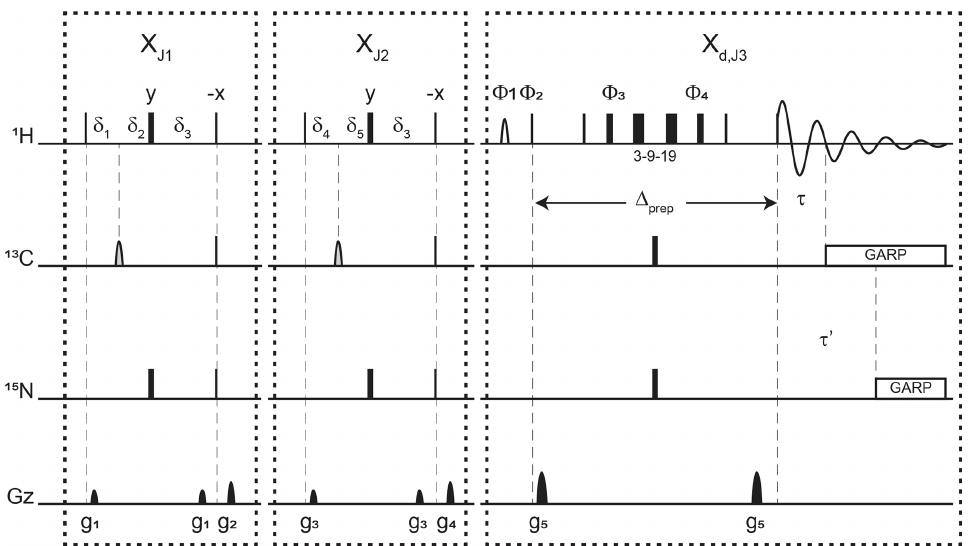
Figure 3. Pulse sequence for a 1-D double X half filter with delayed decoupling for suppression of 13 C (and/or 15 N) labeled protein signals and preservation of unlabeled moieties signals. Dashes indicate different filtering blocks that can be used modularly to suppress scalar coupled spin systems. Here, X denotes isotopic half filters and subscripts J1, J2, and J3 indicate individually targeted scalar couplings. The subscript d indicates our delayed decoupling method. Thin and thick rectangles indicate 90 and 180 ◦ hard pulses, respectively. Unless otherwise noted, the phase of these pulses is along the x axis. Open, half ellipses pulses on carbon are 180 ◦ frequency-swept chirp inversion pulses (Böhlen and Bodenhausen, 1993), with durations of either 500µs, when using sequential-tuned filters, or 1730µs, when using the chemical shift coupling matched sweeping rate (Zwahlen et al., 1997). In Bruker, the shaped pulses were Crp60, 0.5, 20.1, and Crp60_xfilt.2, respectively. Water suppression is achieved through a WATERGATE element in the X d , J3 filter employing a 3–9–19 suppression scheme (Piotto et al., 1992). A water flipped-back pulse (Grzesiek and Bax, 1993) (denoted with a curved open half ellipse) is applied on resonance with water (4.699ppm) using a 1.5ms 90 ◦ sinc pulse. The delays in the X J1 and X J2 filter blocks are δ 3 = 1 / | 4J(NH) | ≈ 2 . 78ms, δ 1 = 1 / | 4J1(CH) | , δ 4 = 1 / | 4J2(CH) | , δ 2 = 1 / | 4J(NH) |− 1 / | 4J1(CH) | , and δ 5 = 1 / | 4J(NH) |− 1 / | 4J2(CH) | . The delays τ and τ (cid:48) in the X d , J3 delayed decoupling block can each be manually set to target residual 1 H − 13 C and 1 H − 15 N signals, respectively. Although we did not need this feature, residual 1 H − 15 N signals can be suppressed using a shared delayed decoupling element that is included in our code. When suppression of surviving 1 H − 15 N signals is not needed, both the 180 ◦ pulse and decoupling sequence on the nitrogen channel can be switched off. The two delays τ and τ (cid:48) are arrayed to find the optimal level of suppression of targeted signals. Decoupling on carbon is performed by applying a globally optimized alternating-phase rectangular pulse (GARP) train (Shaka et al., 1985) on resonance with the targeted signals using a bandwidth of 2.083kHz. Nitrogen decoupling is applied through a GARP sequence using a bandwidth of 1.042kHz. The phase cycling in the delayed decoupling element is (cid:56) 1 = -x, x, (cid:56) 2 = x, -x, (cid:56) 3 = x, x, y, y, -x, -x, -y, -y, (cid:56) 4 = -x, -x, -y, -y, x, x, y, y, and (cid:56) REC = x, -x, -x, x. Gradients are applied with lengths ( τ g i ) and power (g i ) of τ g 1 = τ g 3 = τ g 5 = 300µs (Bruker shape SMSQ10.32), τ g 2 = τ g 4 = 1ms (Bruker